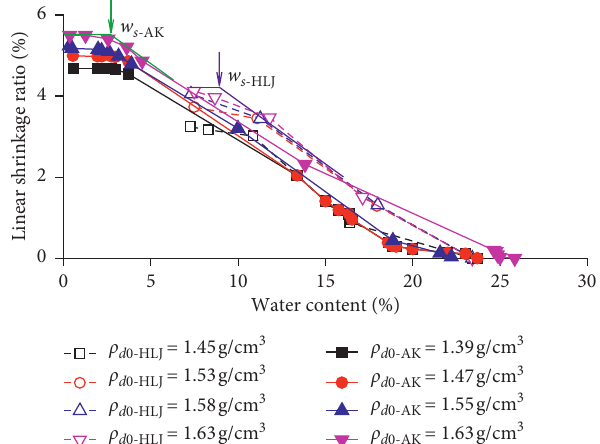
Figure 3: The relationships between vertical linear shrinkage ratio and water content of two expansive soils under different initial dry